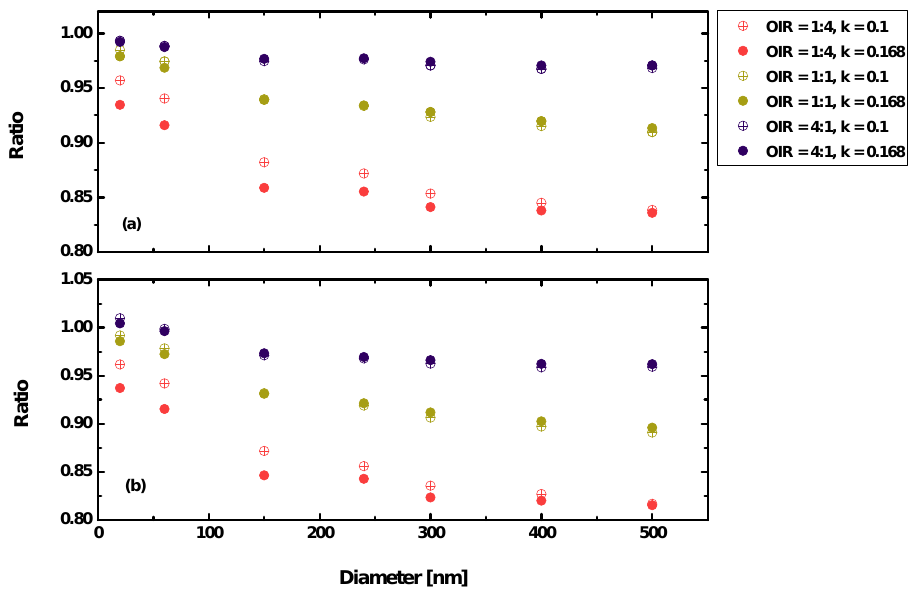
Figure 12. Ratio of radiative forcing of LLPS to the homogenous case under 70%RH (a) and dry conditions (b) for AAE = 6 and albedo a =